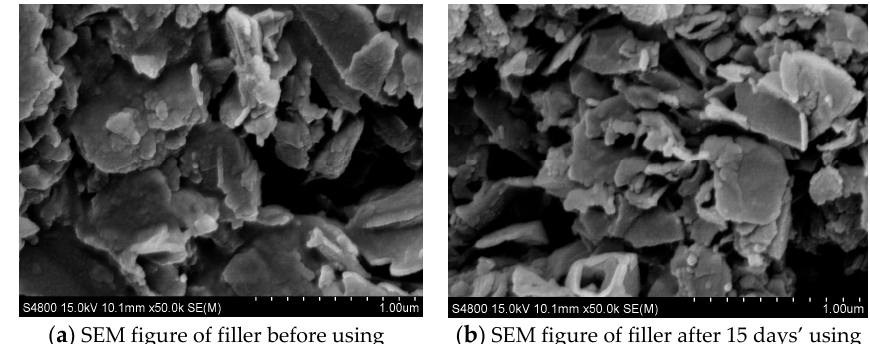
Figure 13. SEM contrast figure of filler before and after using. ( a ) SEM figure of filler before using and ( b ) SEM figure of filler after 15 days’ use.